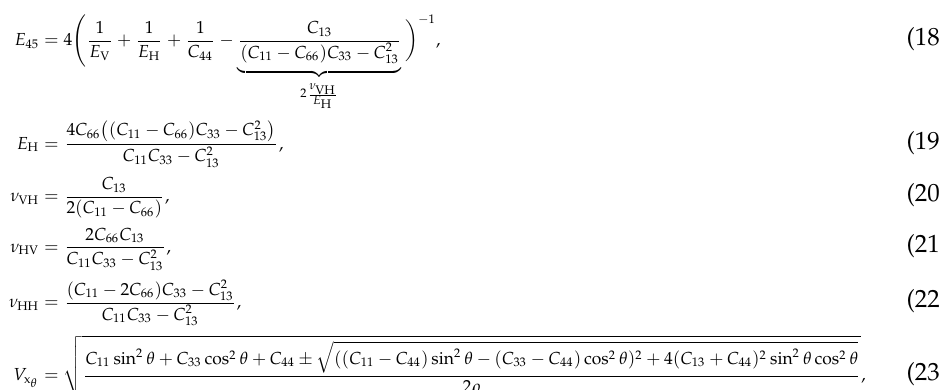
where C 11 , C 13 , C 33 , C 44 , and C 66 are the predefined stiffnesses. Figure 11 also includes (absolute value) Cole–Cole modeled attenuation (dashed lined) to compliment dispersion (solid lines) but remains unelaborated due unreliable phase measurements (caused by minor misalignments [75]) that were later resolved [76,80].